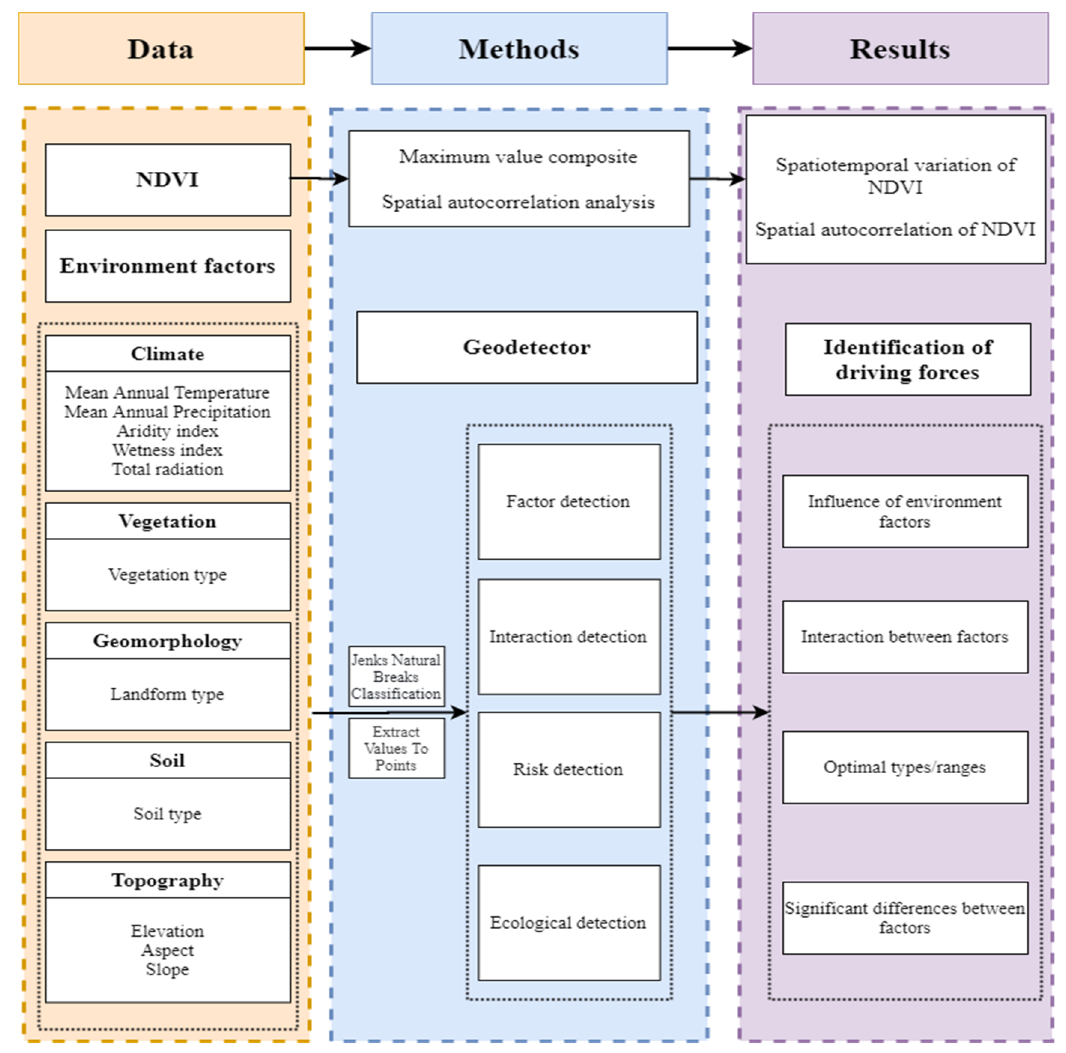
Figure 3. Diagram of workflow in this study.